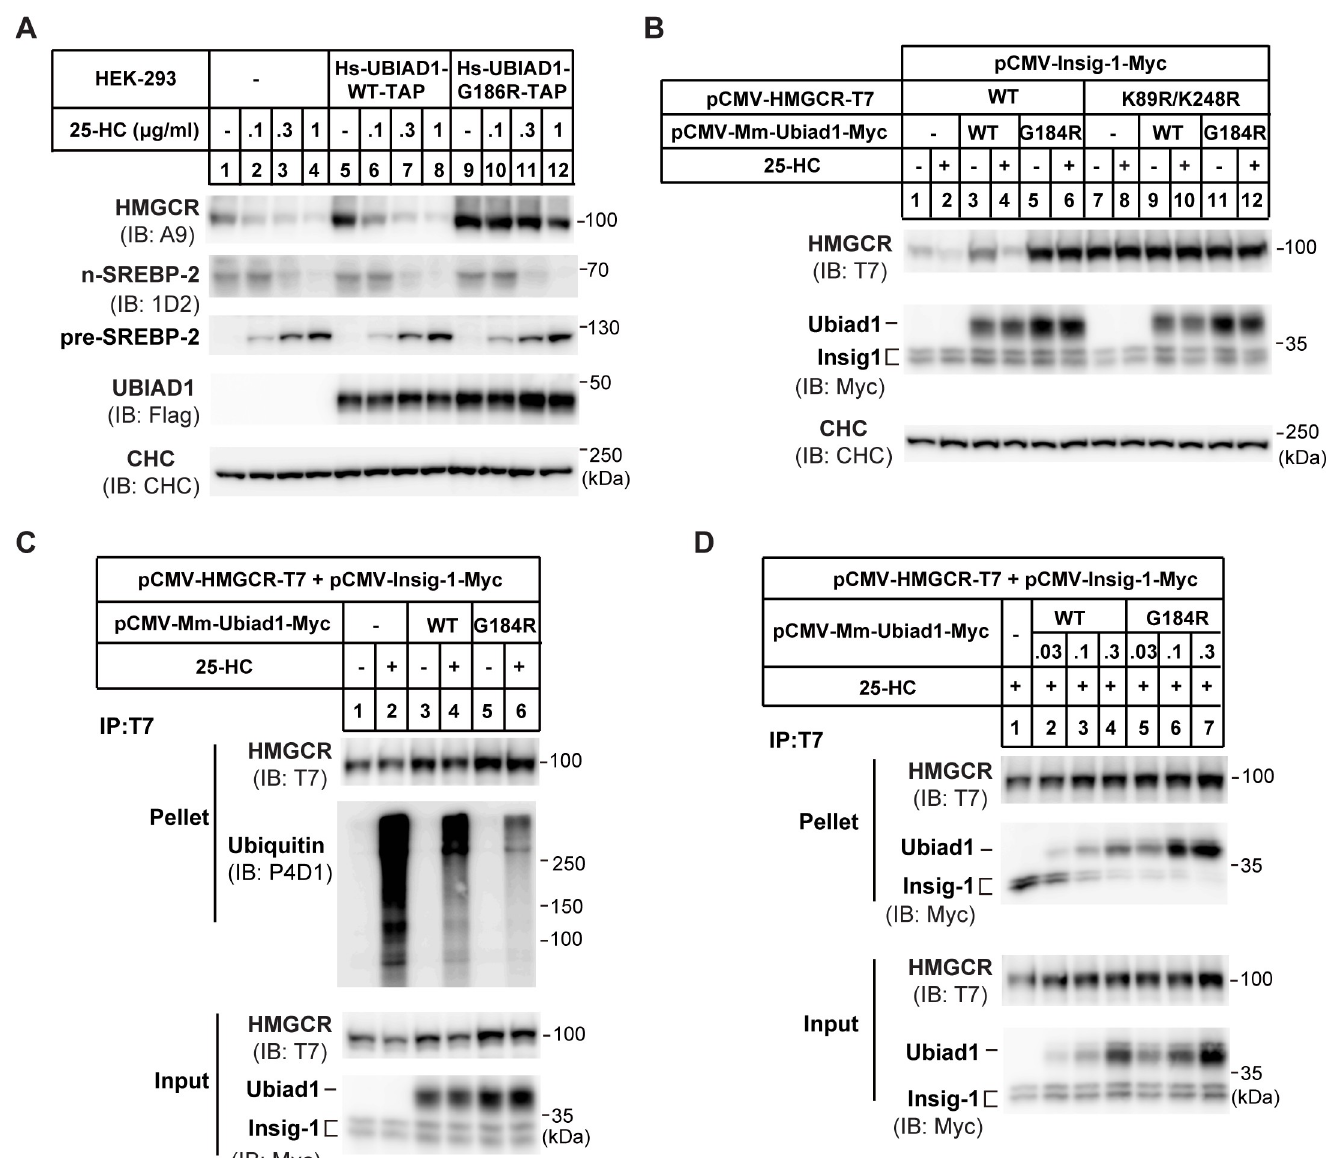
Fig 1. UBIAD1 (G186R) blocks the ubiquitination and degradation of HMGCR. (A) Effects of human wild-type (WT) UBIAD1 and mutated UBIAD1 (G186R) (equivalent to mouse G184R) on HMGCR protein level. HEK-293 cells stably expressing human (homo sapiens, Hs) WT UBIAD1-TAP and UBIAD1 (G186R)-TAP, respectively, were depleted of sterols in sterol-depleted medium containing 10% LPDS, 1 μ M lovastatin and 50 μ M mevalonate for 16 hr. Then indicated concentrations of 25-hydroxylcholesterol (25-HC) were added and incubated for 5 hr. Cells were harvested and subjected to immunoblot with antibodies against HMGCR (A9), SREBP-2 (1D2), and UBIAD1 (anti-Flag). Clathrin heavy chain (CHC) was a loading control. TAP: Flag-Protein A tags for tandem affinity purification in S1 Fig. (B) Effects of mouse WT and G184R Ubiad1 on the degradation of the ubiquitin sites mutated (K89R/K248R) HMGCR. CHO-K1 cells were transfected with indicated plasmids, depleted of sterols for 16 hr and treated with 1 μ g/ml 25-HC and 10 mM mevalonate (Mev) for 5 hr. Lysates were immunoblotted with indicated antibodies. Mus musculus, Mm. (C) Effects of WT and G184R Ubiad1 on the ubiquitination of HMGCR. CHO-K1 cells were transfected and depleted of sterols, then cells were treated with1 μ g/ml 25-HC, 10 mM mevalonate and 20 μ M MG-132 for 2 hr before immunoprecipitation. Lysates were immunoprecipitated with anti-T7 antibody coupled agarose, and pellets and inputs were probed for indicated proteins. (D) Interaction between Ubiad1 and HMGCR. CHO-K1 cells were transfected, depleted of sterols and treated with 25-HC for 1 hr, then lysates were immunoprecipitated with anti-T7 antibody coupled agarose. Pellets and inputs were probed with indicated antibodies. The experiments are repeated three times and representative data are shown.